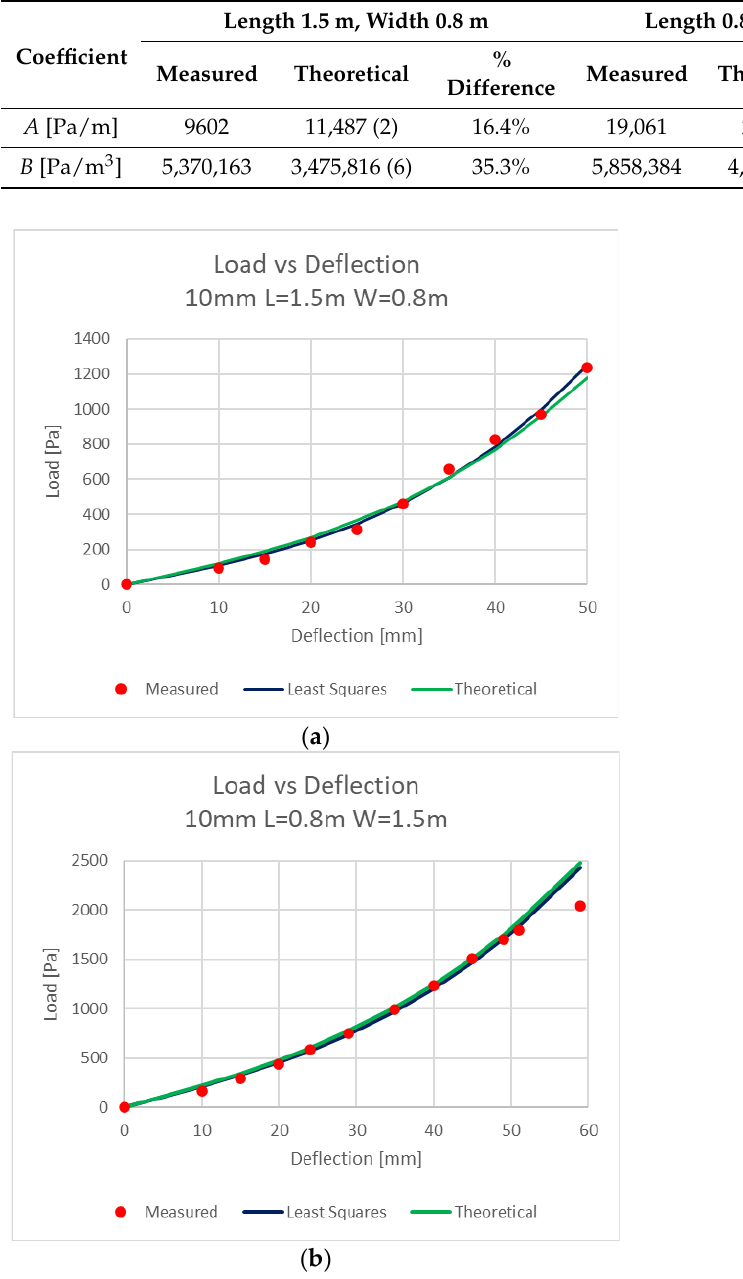
Figure 5. Load – Deflection graphs: ( a ) length 1.5 m, width 0.8 m; ( b ) length 0.8 m, width 1.5 m. Table 1. The elastic constants of this multiwall plate.